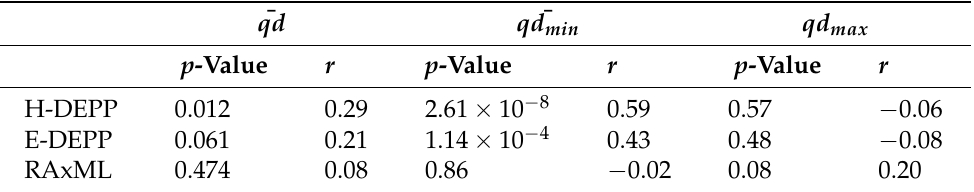
Table 2. Drives of errors in updating trees. We show the correlation between the errors of the estimated tree measured by quartet distance and ¯ qd : mean of QD , ¯ qd min : mean of the minimum two values in QD , and qd max : maximum value in QD , where QD is the set of quartet distances between the gene trees corresponding to each input gene and the species tree. We use Wald test on the linear least-square regression with the null hypothesis of zero slope. r : the Pearson correlation coefficient. ¯ qd ¯ qd